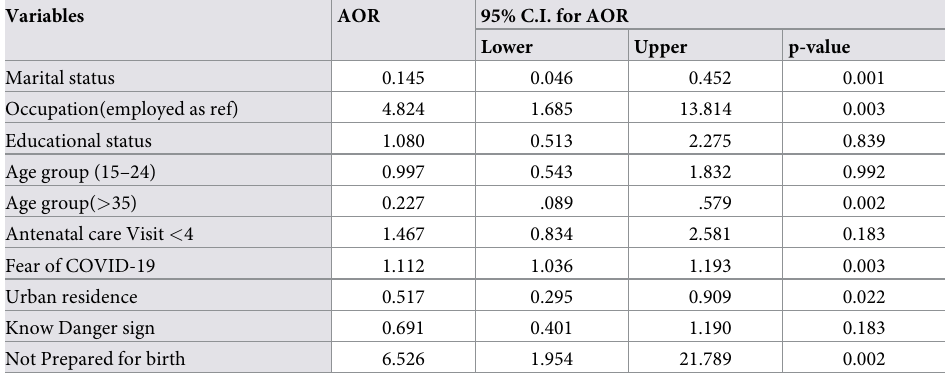
Table 3. Multivariable regression results for factors associated with the first maternal delay among pregnant women in Ilubabor zone, Southwest Ethiopia, February to April 2021 ( n = 402).